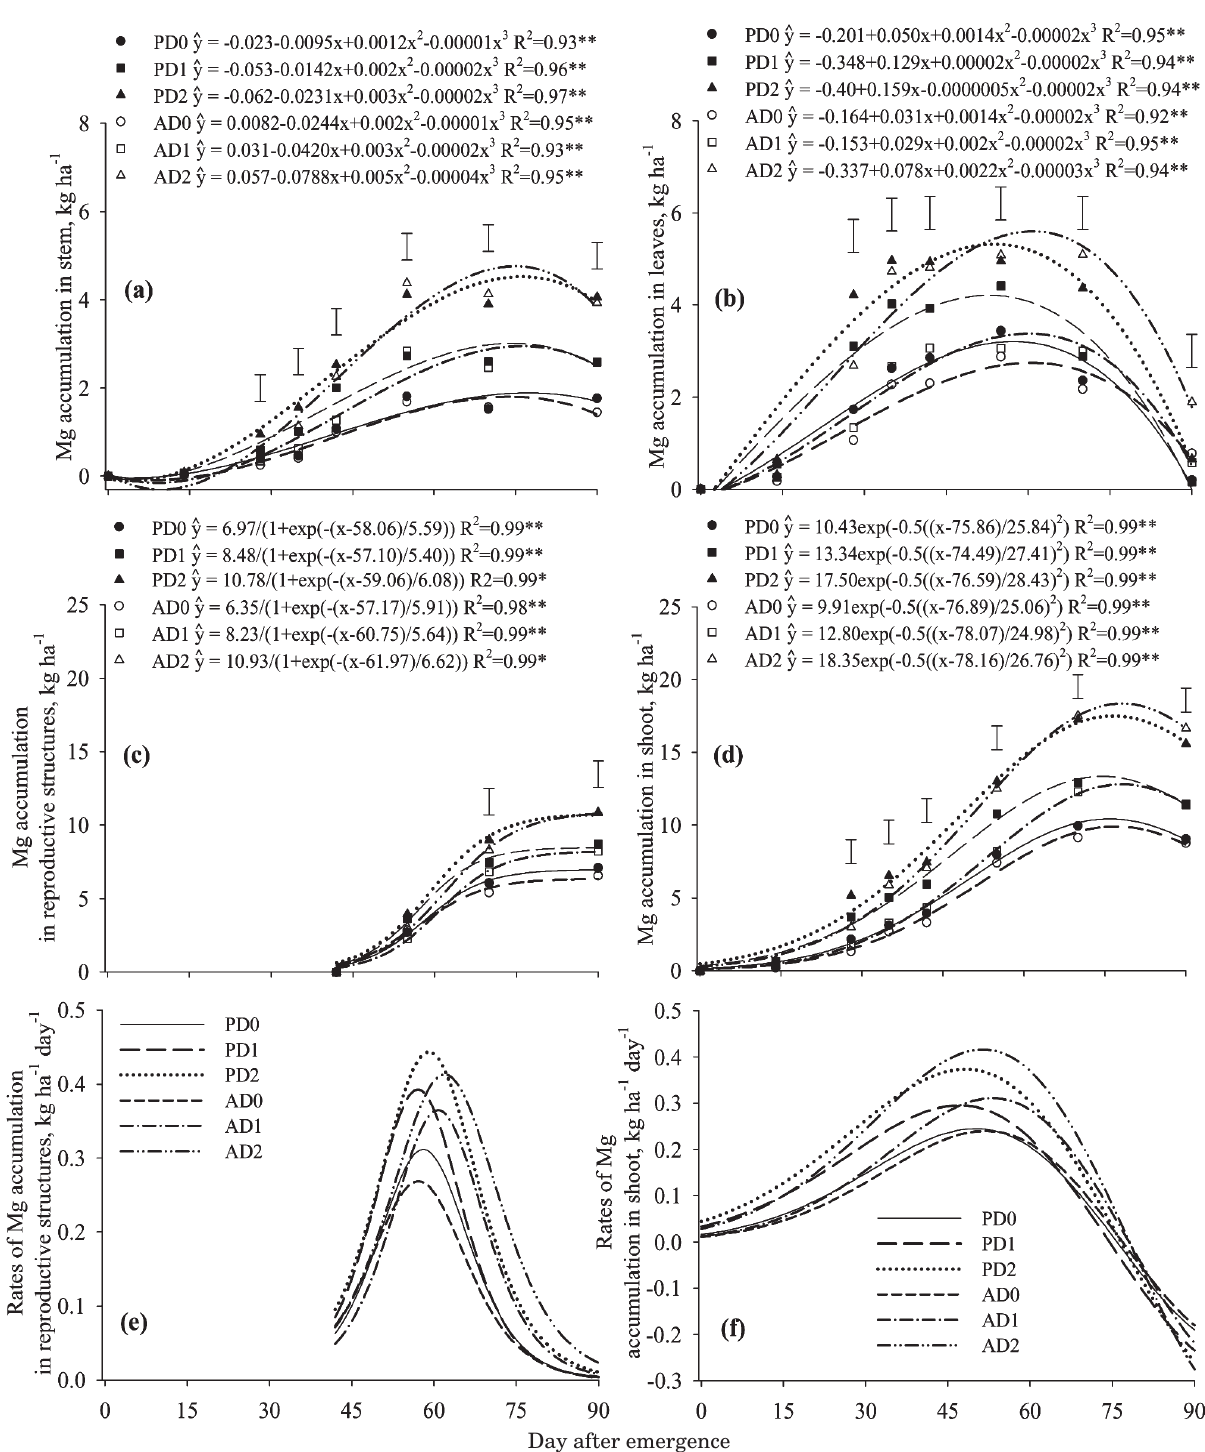
Figure 6. Magnesium accumulation in stem (a), leaves (b), reproductive structures (c), and shoot (d) and rates of accumulation of Mg in reproductive structures (e) and shoot (f) of common bean cultivars, under different levels of fertilization. ** and * are: significant at p 0.01 and p 0.05 by the F test. Vertical bars represent the Least Significant Difference (LSD) at p 0.05. PD0 = Pérola without NPK fertilization, PD1 = Pérola with 50 % of recommended NPK fertilization; PD2 = Pérola with 100 % of recommended NPK fertilization; AD0 = IAC Alvorada without NPK fertilization, AD1 = IAC Alvorada with 50 % of recommended NPK fertilization; AD2 = IAC Alvorada with 100 % of recommended NPK